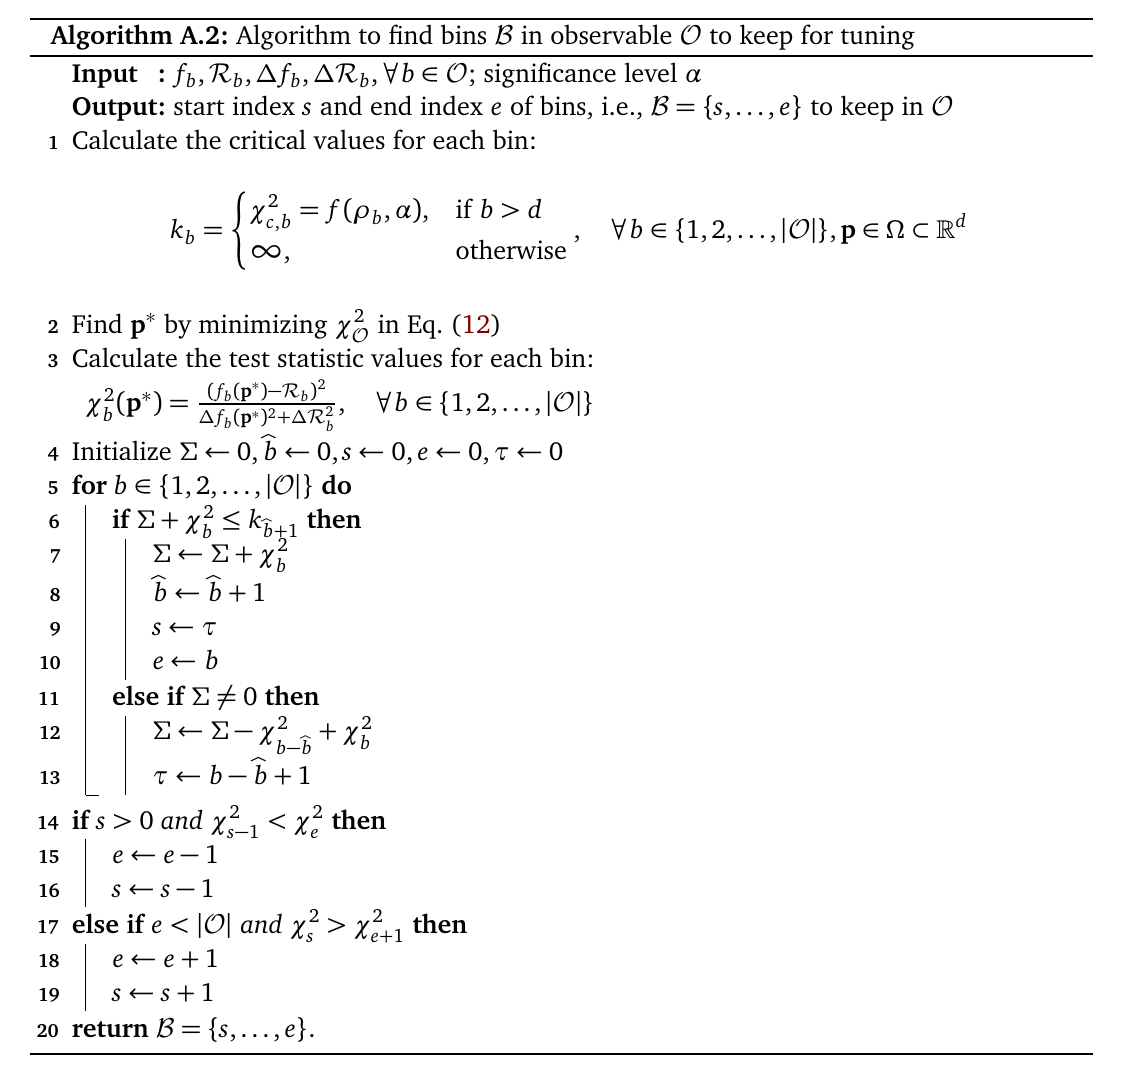
Algorithm A.2: Algorithm to find bins